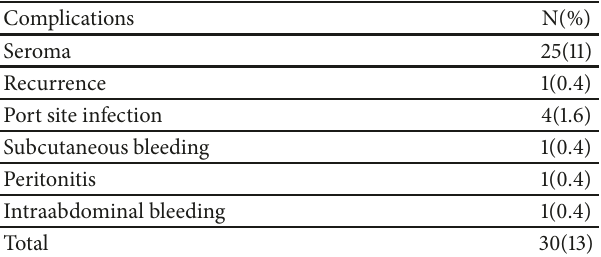
Table 1: Postoperative complications following TAPP.